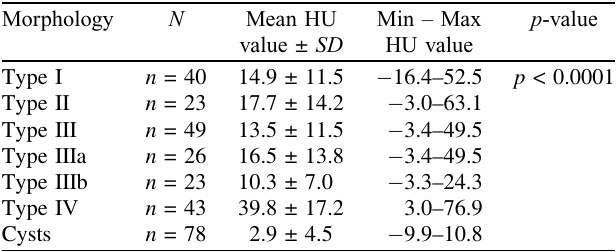
Table 1. Patient characteristics in the study group ( n = 155) and the control group ( n =